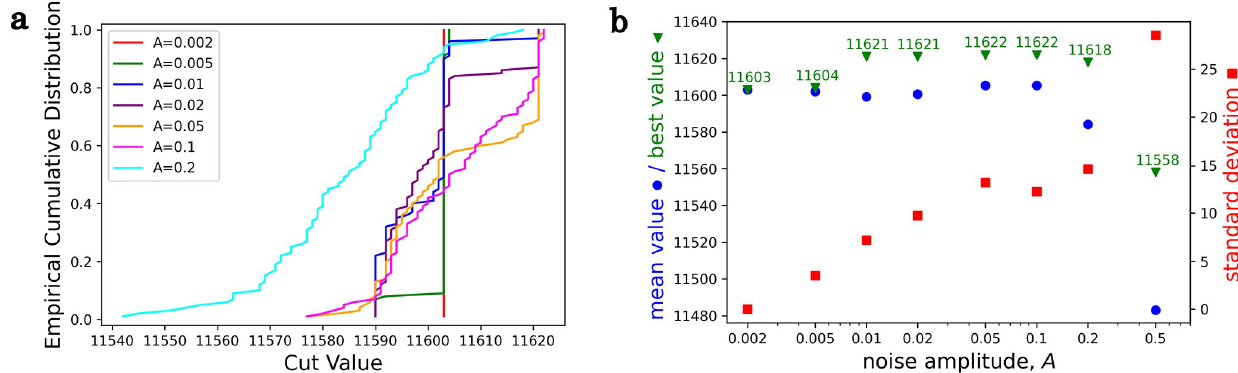
Fig 2. a, Empirical Cumulative Distribution of the Cut Values of G3 for different external magnetic field amplitudes. b, Mean value, best value and standard deviation of the Cut Values of G3 for different external magnetic field amplitudes.